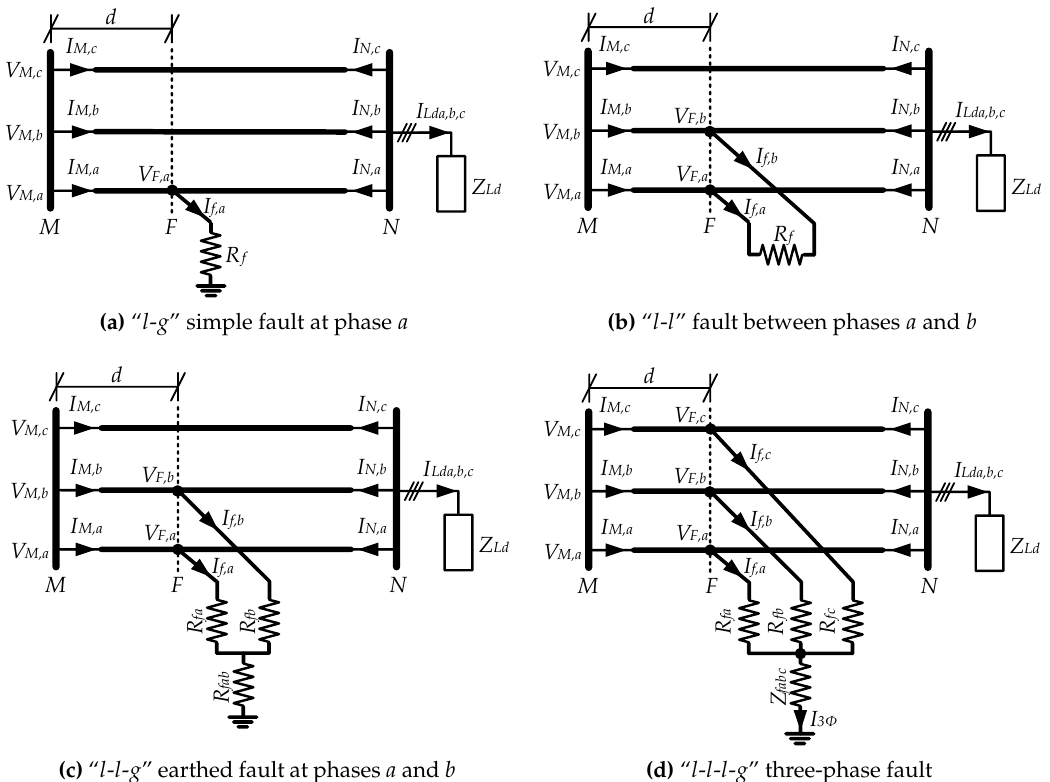
Figure 3. Simplified model of a faulted section in the Salim et al. method